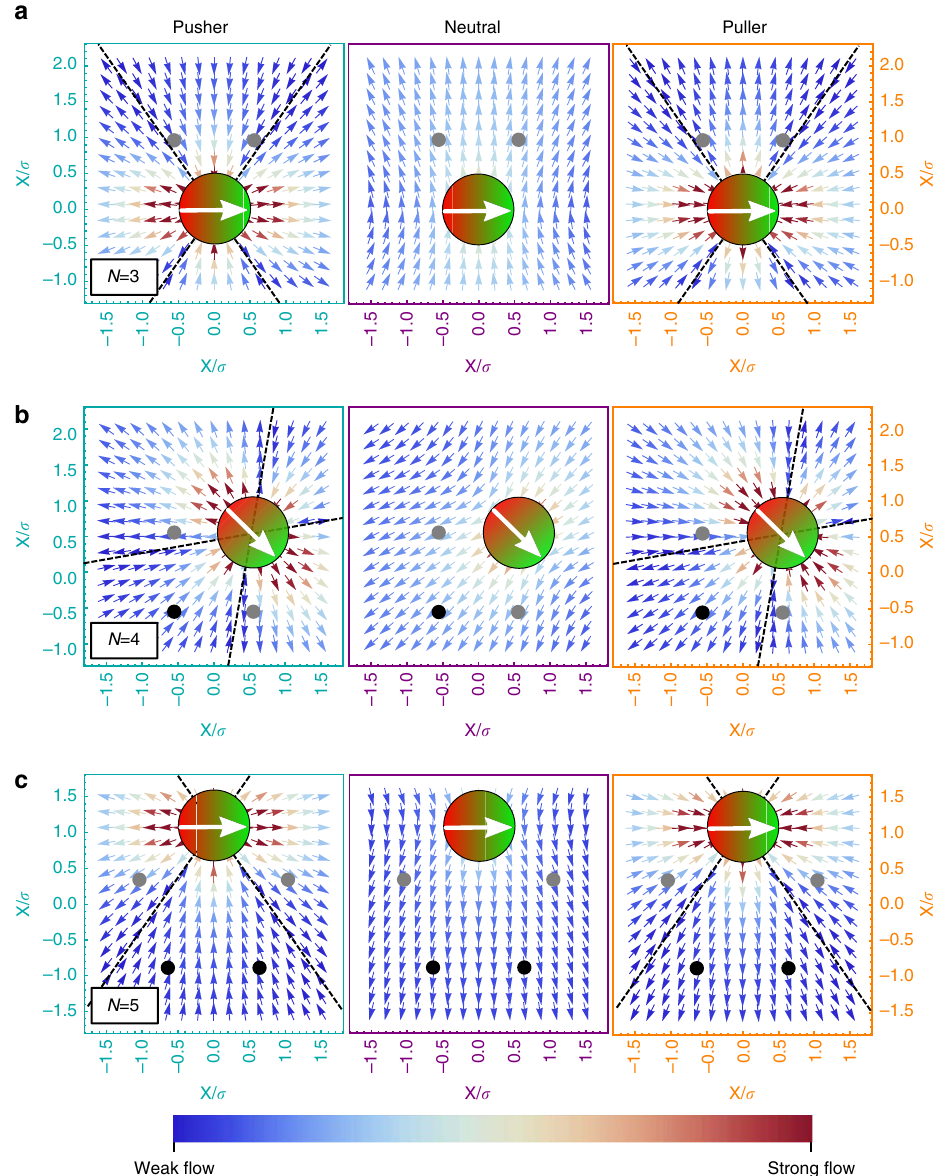
Figure 5 | Flow-field of a single swimmer within a ring-like cluster. Flow field generated by a single (left) pusher, (middle) neutral swimmer and (right) puller. Dots indicate the positions of nearest (grey dots) and next nearest neighbours (black dots) for ( a ) a ring-like cluster of N ¼ 3, ( b ) N ¼ 4 and ( c ) N ¼ 5. The dashed lines indicate the transition from inwards to outward flow. The magnitude of the flow is indicated by the colour code varying from dark blue (weak flow) to dark red (strong